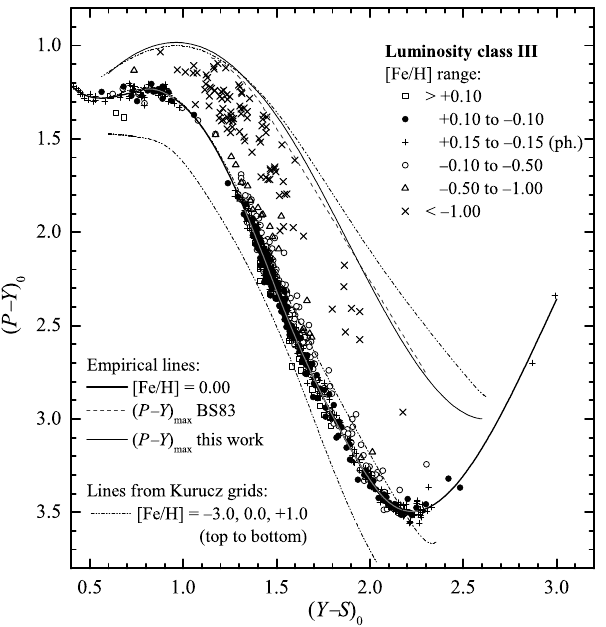
Fig. 6b. P – Y vs. Y – S diagram for giant stars. Symbols the same as in Figs. 4